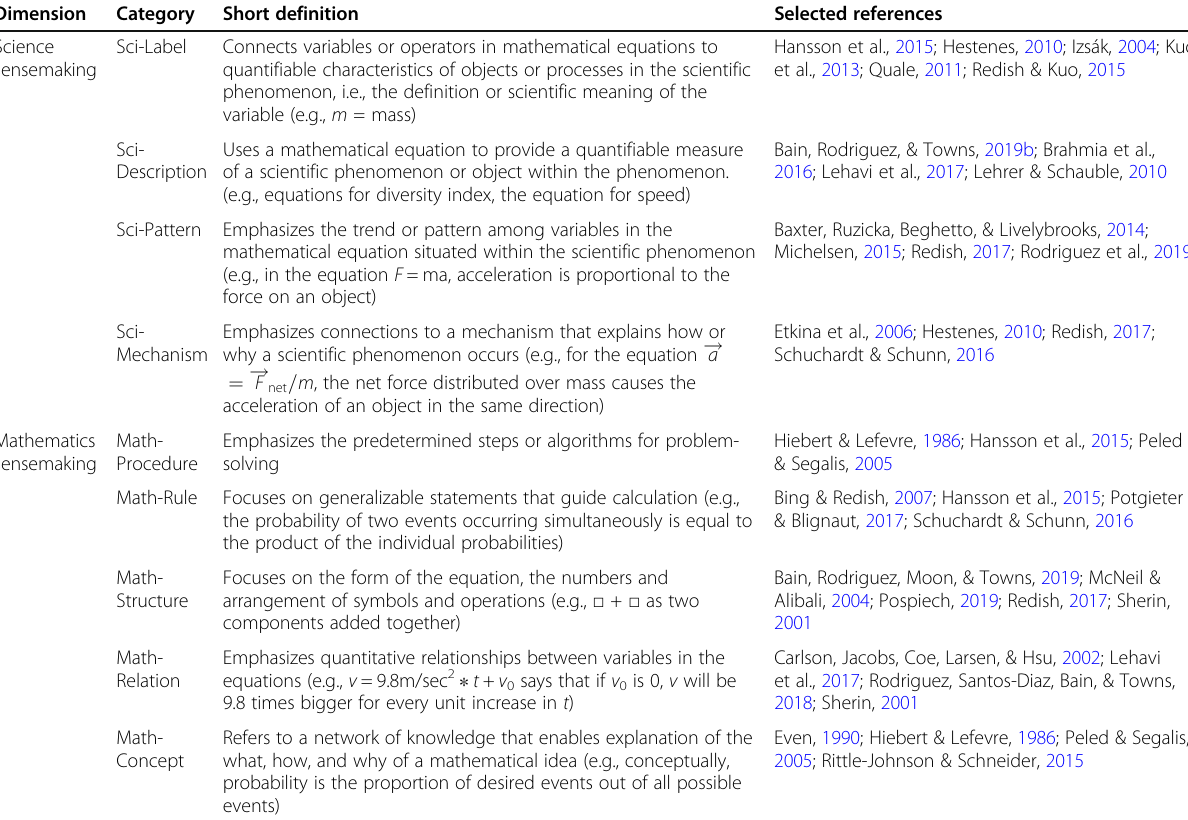
Table 2 Categories synthesized from literature to capture the sensemaking opportunities of mathematical equations in science